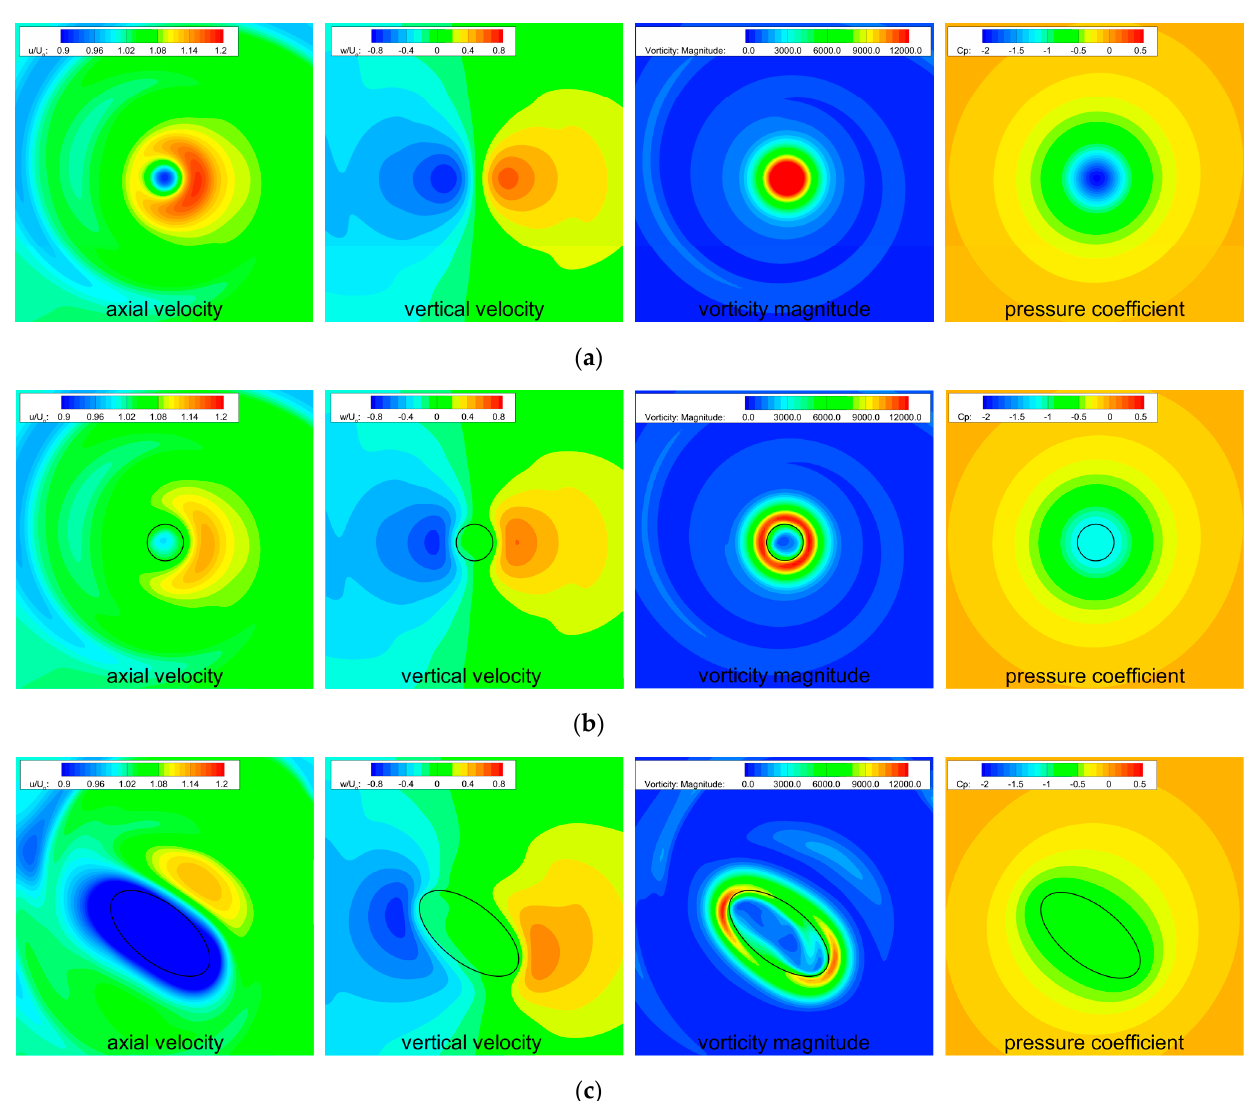
Figure 13. Pressure, axial and vertical velocity and vorticity magnitude distributions at x/c = 1.0 for different flow conditions: ( a ) wetted flow condition; ( b ) cavitating flow condition, 𝜎 = 1.15; ( c ) cavitating flow condition, 𝜎 = 0.58.